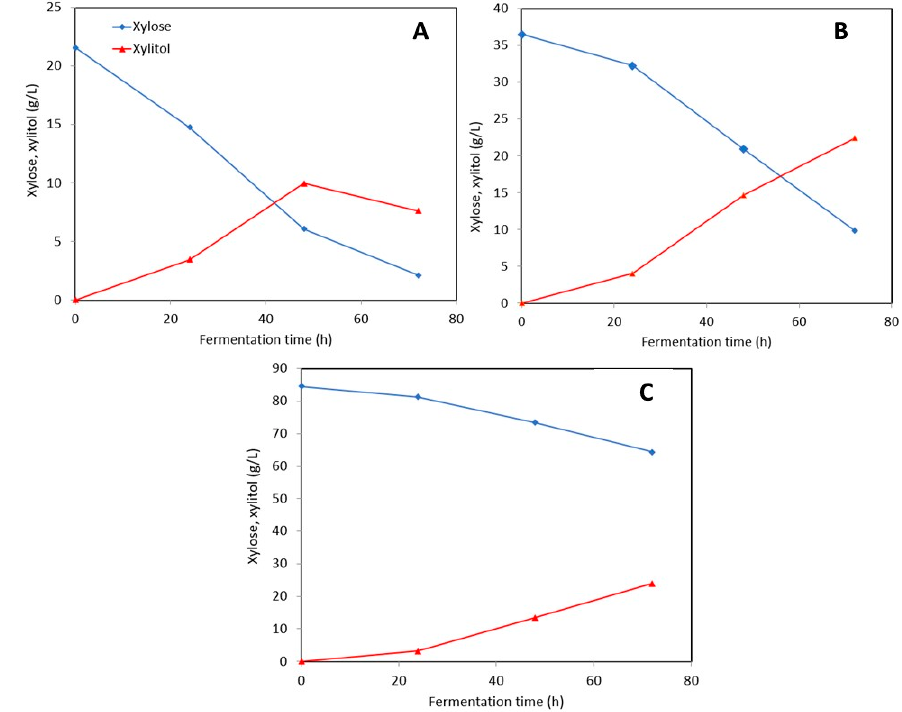
Figure 2. Concentration profiles of xylose ( ♦ ) consumption and xylitol ( ▲ ) generation by C. mogii cultivated in synthetic media with xylose as the sole carbon source at initial concentrations of ( A ) 22.2 g / L, ( B ) 44.4 g / L, and ( C ) 88.8 g / L.